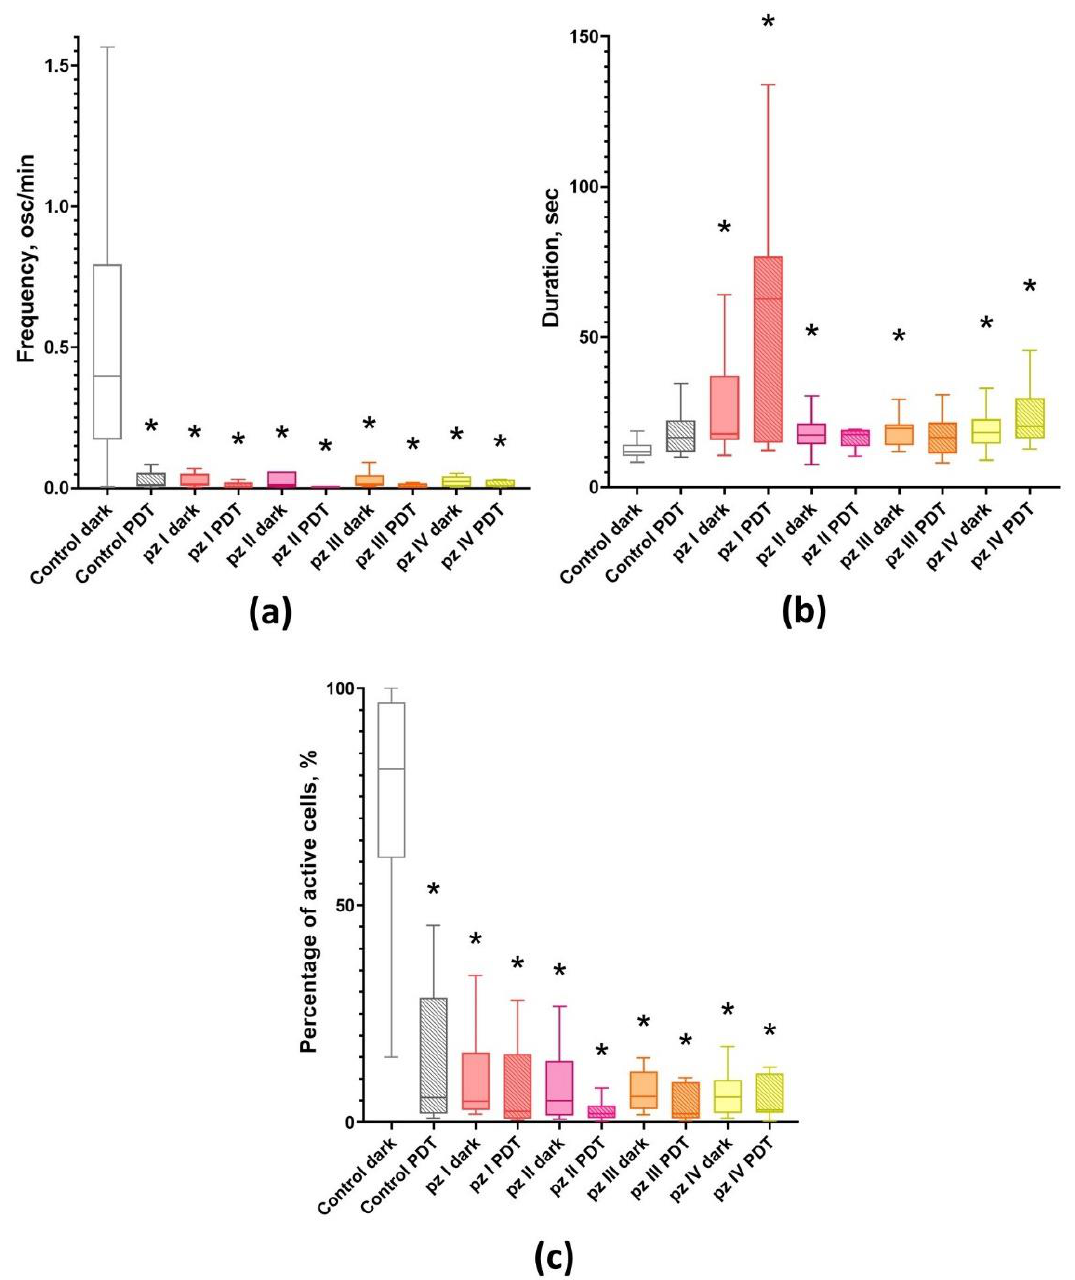
Figure 2. Main parameters of functional calcium activity in primary hippocampal cultures the next day after PDT. ( a ) Number of Ca 2+ oscillations per min; ( b ) duration of Ca 2+ oscillations; ( c ) propor- tion of cells exhibiting Ca 2+ activity. * versus “Control dark”; # versus “Control PDT”, ● versus the same pz dark group, p < 0.05, Kruskal – Wallis test. It was shown that, normally (“Control dark” group), the cells in the neuron-glial network form multiple connections (897.18 [735.53; 976.14] connections in each cell on average) and have a high level of signal speed propagation (0.66 [0.57; 0.77] µ m/s), which corresponds to the 14th–15th days of culture development in vitro